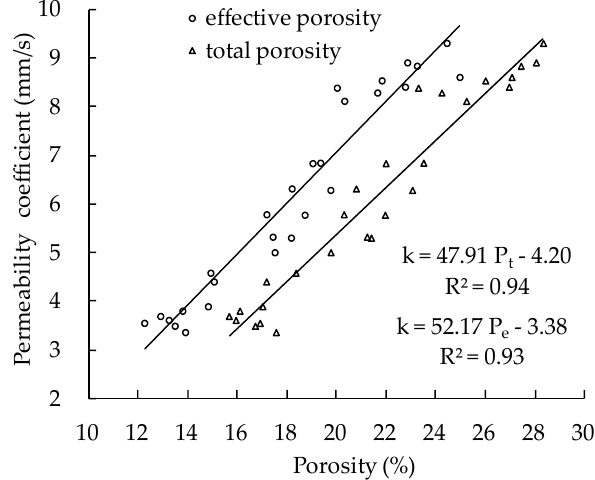
Figure 6. Relationship between permeability coefficient and porosity.